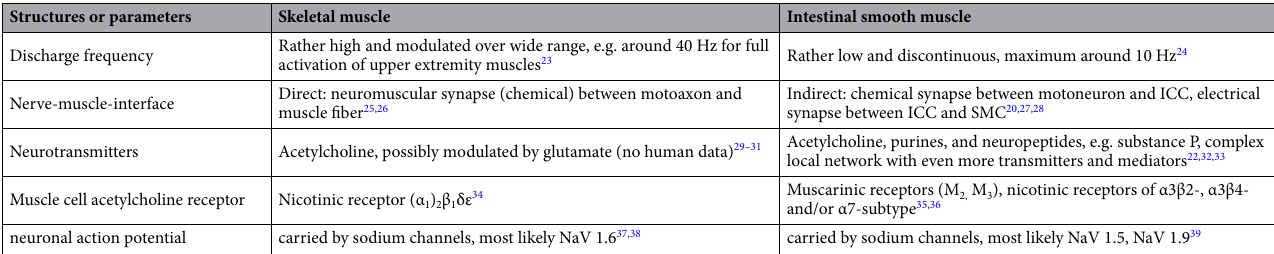
carcinoma-patients, the histopathology of the resected colon segments from which the material used in this study had been taken confirmed that they were free of tumor cells. Neuromuscular alterations and clinical parameters of critically ill patients. Compared to the 43 patients whose nerves and muscles were studied, the amplitudes of compound muscle action potentials (CMAP) were significantly higher in healthy controls (Fig. 1D). Furthermore, irrespective of the time point of measure- ment, CMAP-amplitudes obtained from the Musculus abductor digit minimi (ADM) were larger than from the